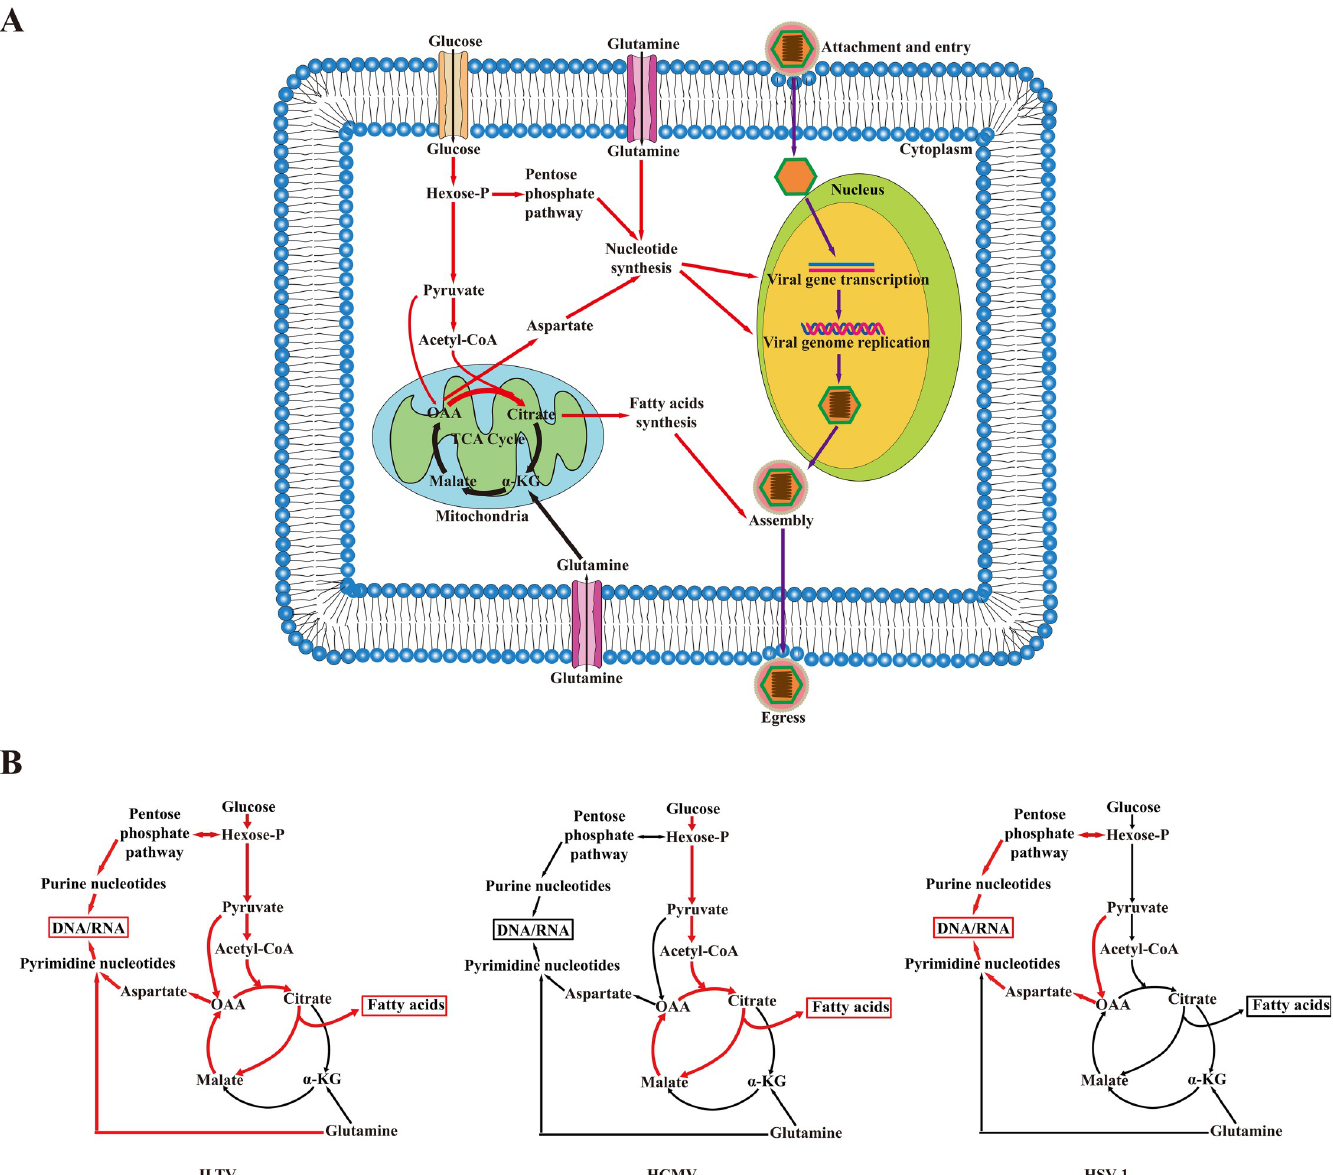
Fig 9. A speculative model summarizing the metabolic requirements of ILTV replication. (A) Glycolysis, glutamine metabolism, and fatty acid synthesis are required for different steps of ILTV replication. Both glycolysis and glutamine metabolism are required for early viral gene expression, while fatty acid synthesis contributes to viral assembly and viral egress but not viral gene transcription. (B) Divergent effects of ILTV, HCMV and HSV-1 on central carbon metabolism. Schematic summary of the major host metabolite concentration changes and speculative flux changes in response to ILTV (left panel) according to the findings of present study and the metabolite concentration and flux changes in response to HCMV (middle panel) and HSV-1 (right panel) infection proposed by previous study [2]. Arrow colors denote flux changes (red, metabolic flux promoted by ILTV infection; black, no effect). (Hexose-P: glucose-6-phosphate and its isomers; α -KG: α -ketoglutarate; OAA: